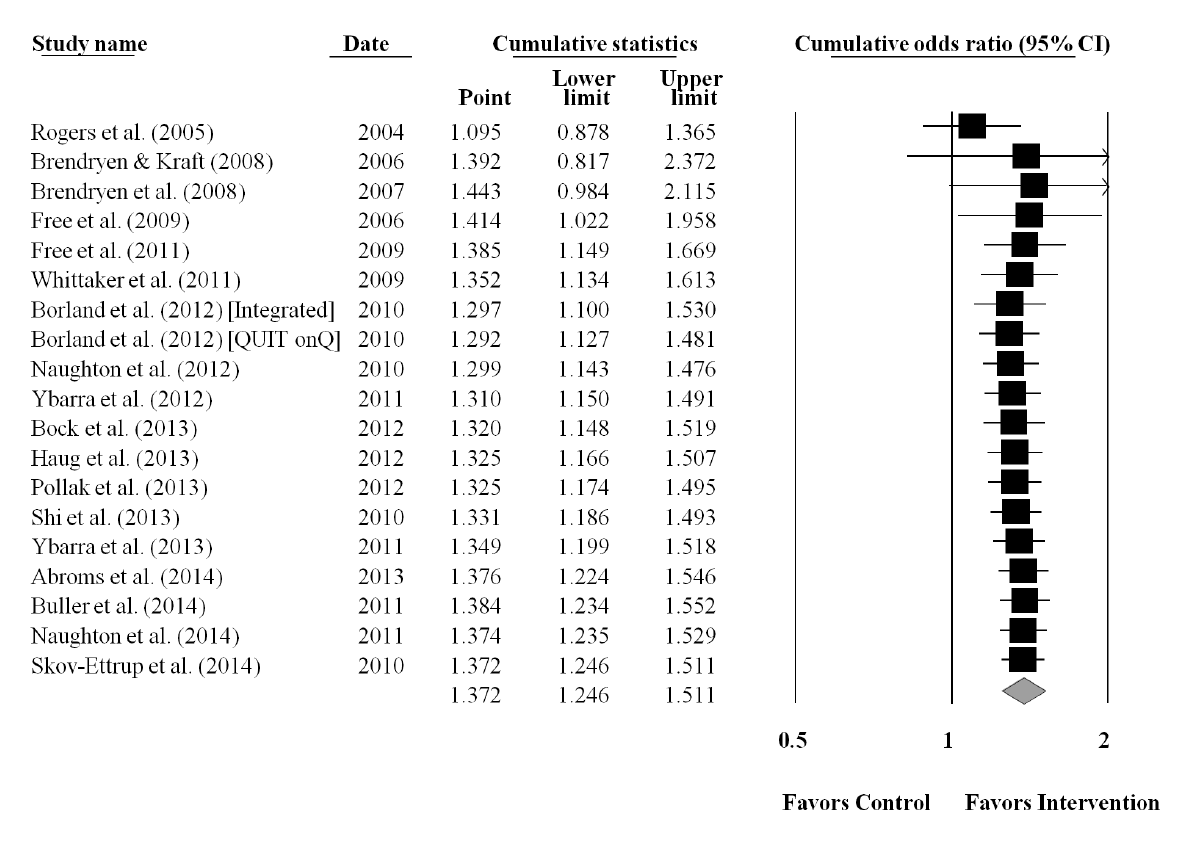
Figure 3. Cumulative plot of the overall weighted mean effect sizes and the corresponding 95% confidence intervals for smoking abstinence, based on final date of data collection.